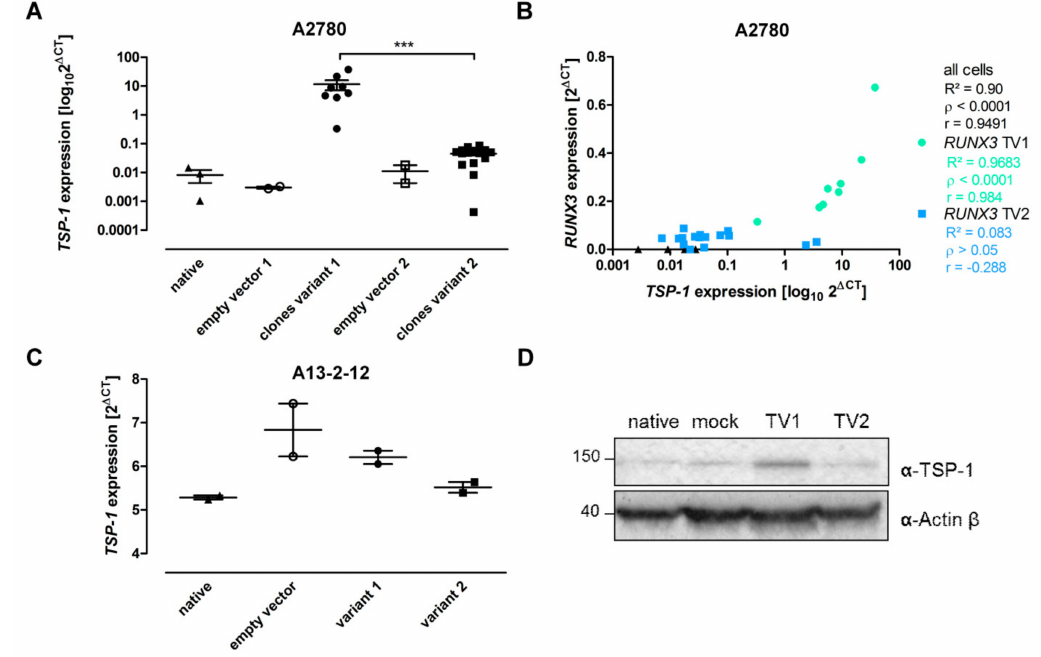
Figure 5. Thrombospondin-1 expression regulation by RUNX3 . ( A ) TSP-1 mRNA expression in A2780 cells. n ≥ 2, *** p < 0.001 in Student’s t -test. ( B ) Correlation between RUNX3 expression and TSP-1 expression in A2780 RUNX3 single- cell clones. The expression of RUNX3 TV1 significantly correlated with TSP-1 expression. n (clones) ≥ 8 in Pearson’s correlation. ( C ) TSP-1 mRNA expression in A13-2-12 cells, n ≥ 2. ( D ) Detection of TSP-1 in A13-2-12 cells by Western blot proved a stronger upregulation of TSP-1 protein after RUNX3 TV1 overexpression. Actin- β was used as loading